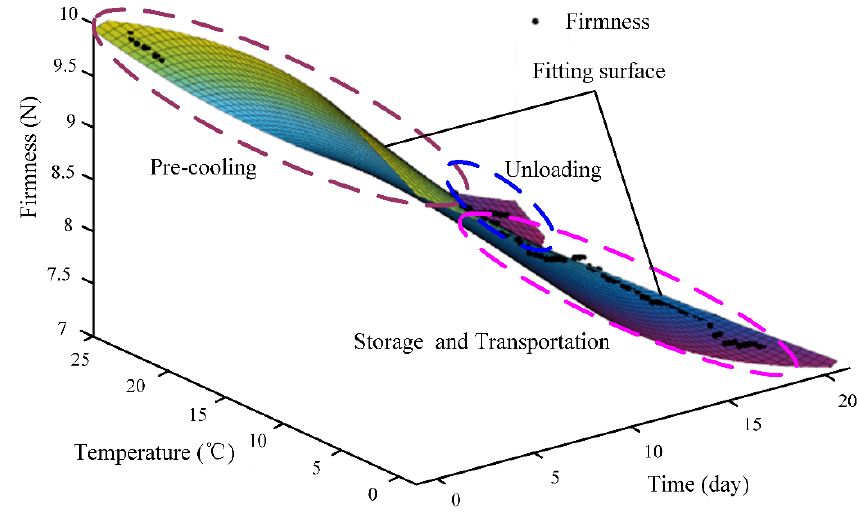
Figure 7. Firmness of table grapes in the cold